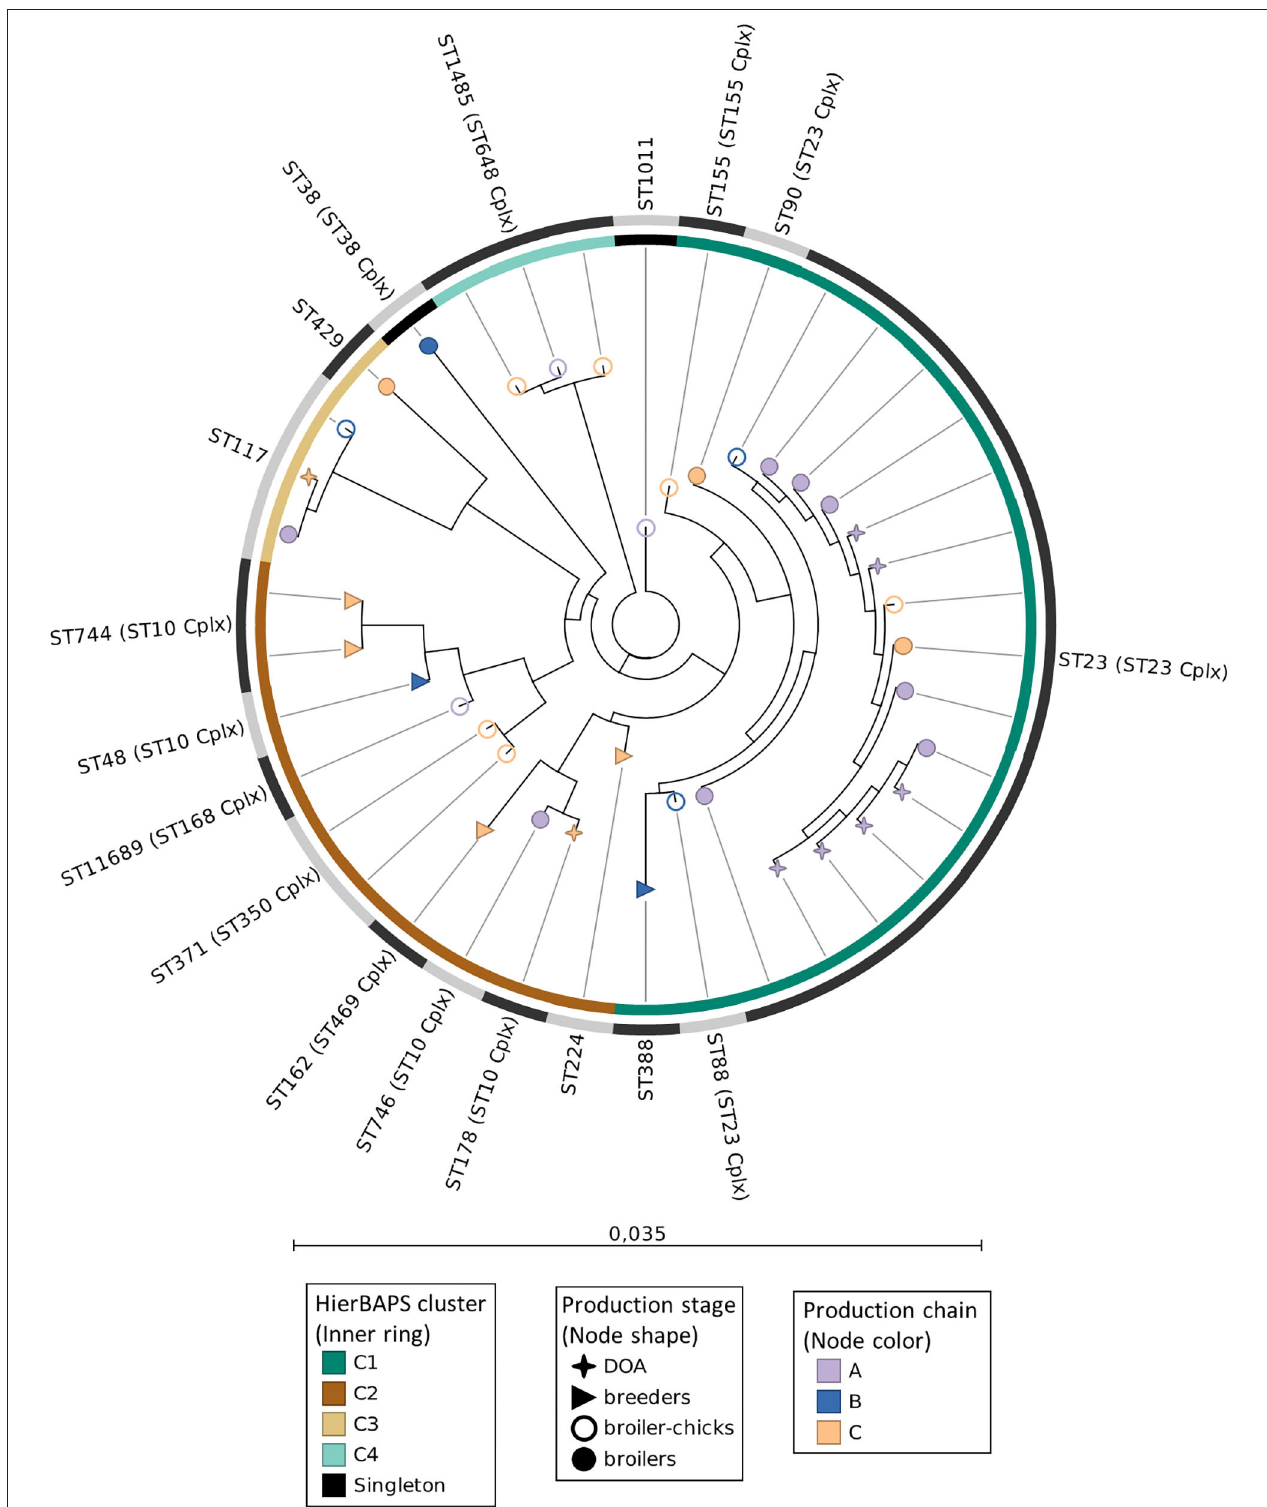
FIGURE 2 | Maximum-likelihood phylogeny of APEC MLST sequences. Nodes’ shape and color indicate the broiler production stage and production chain, respectively. The inner ring specifies the hierBAPS clusters. The outer ring with alternating dark and light gray segments, marks different STs. Scale bar refers to the branch lengths, which are measured in the number of substitutions per